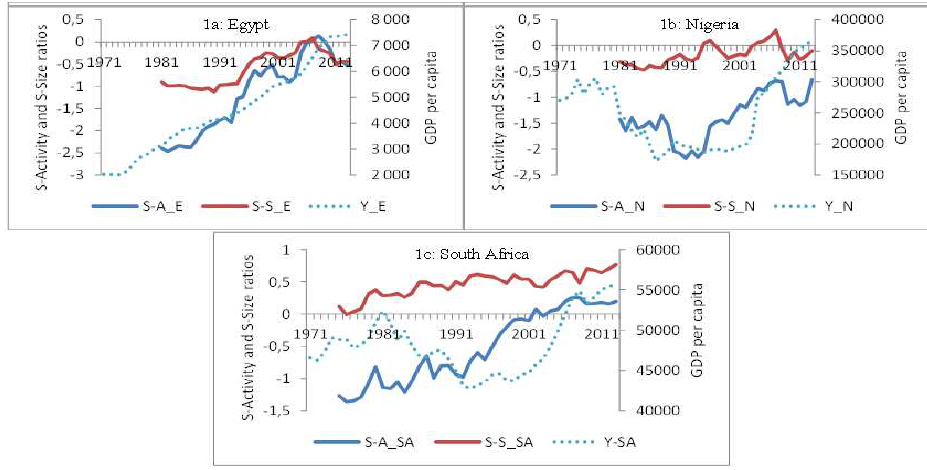
Fig. 1. Co-movement between financial structure and per capita GDP for Egypt, Nigeria and South Africa: